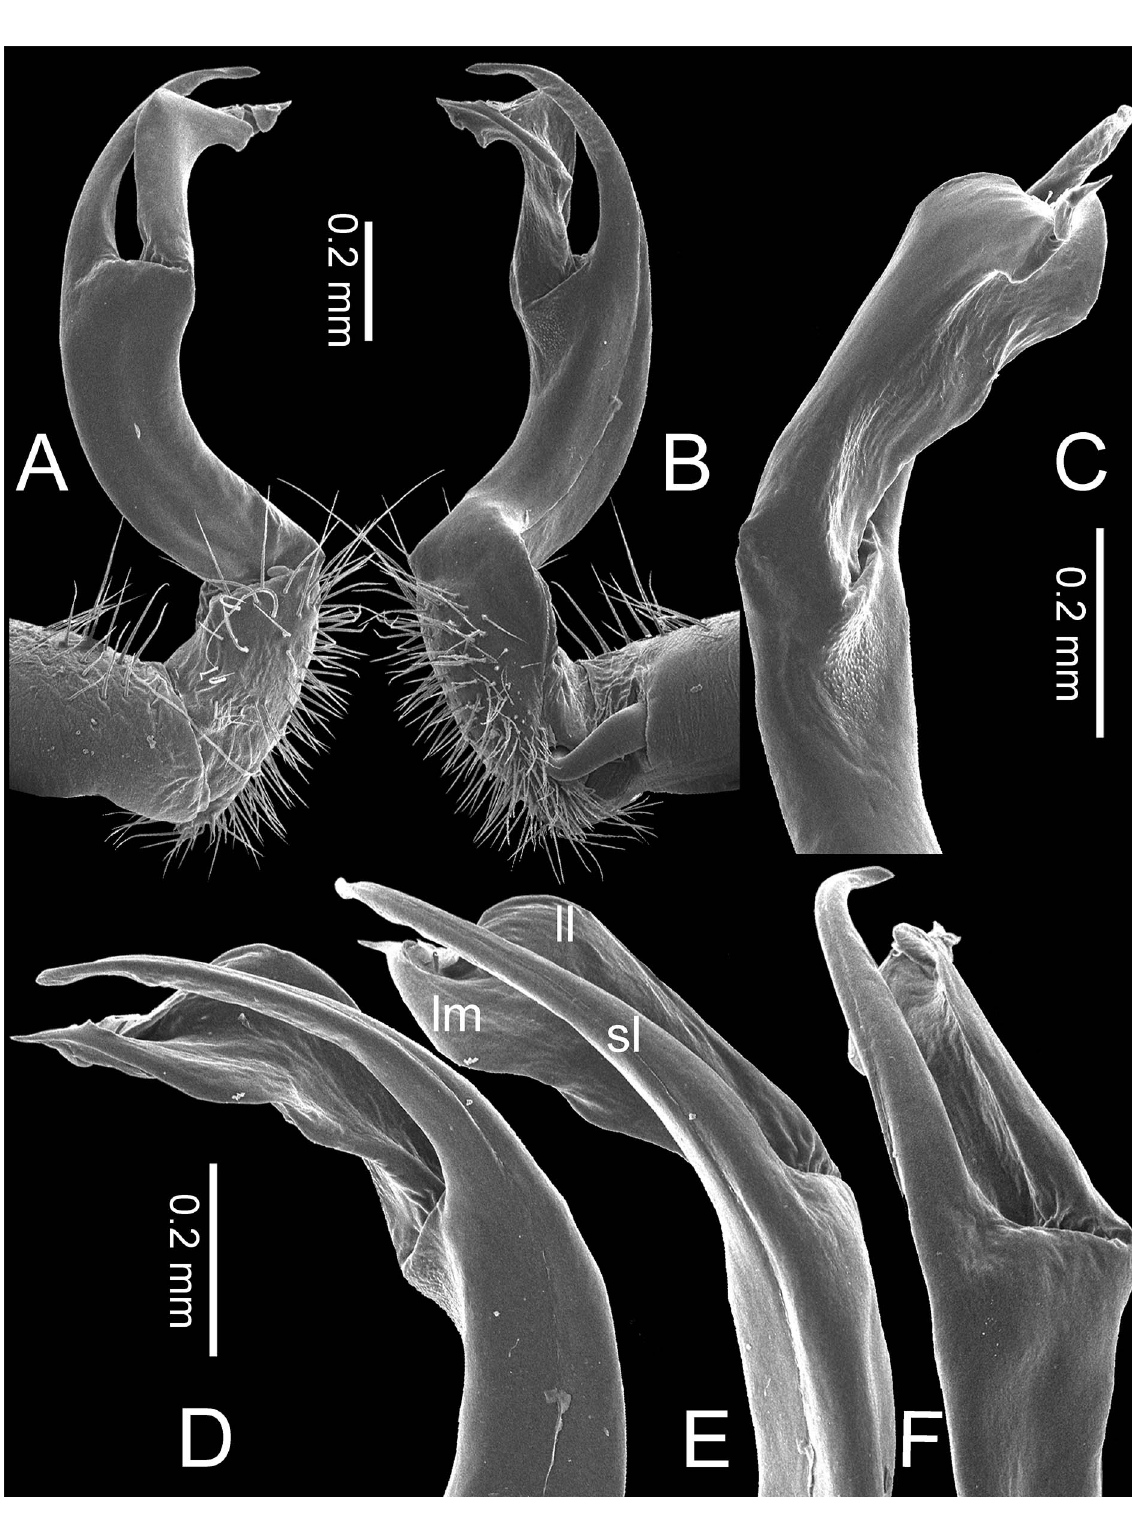
Fig. 8. Gigaxytes fusca Srisonchai , Enghoff & Panha gen. et sp. nov., ♂ paratype – right gonopod. A. Lateral view. B. Mesal view. C. Ventral view. D, F. Subdorsal view. E. Dorsal